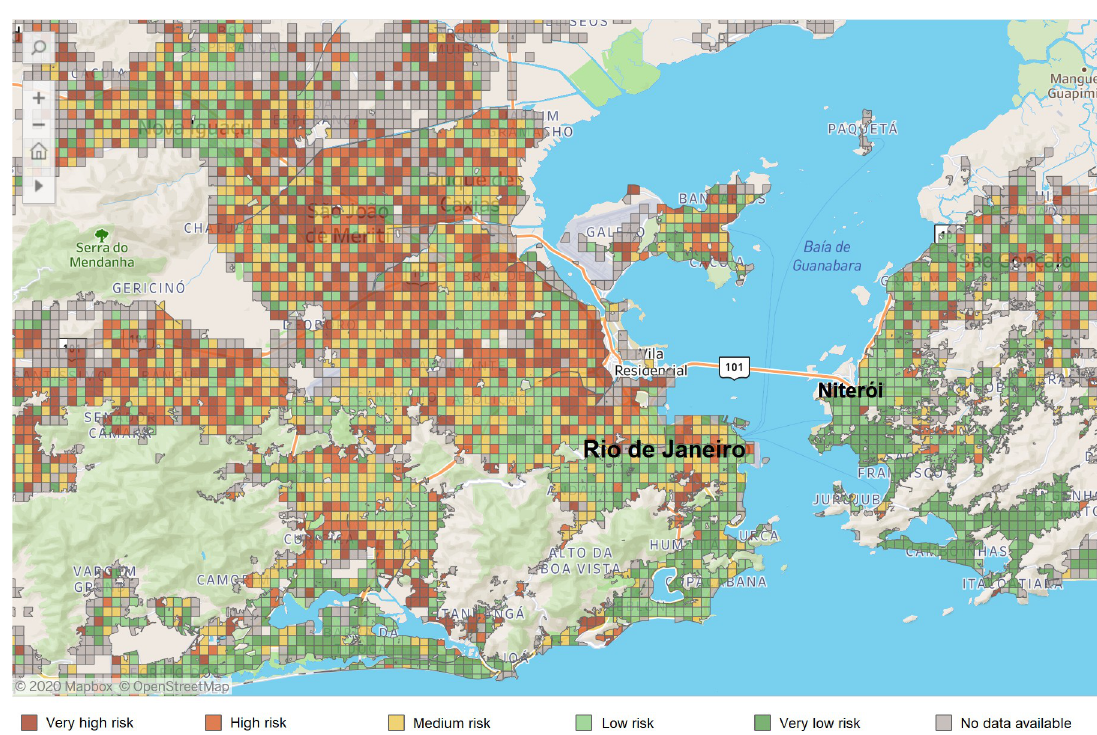
Fig 4. SARS-CoV-2 infection risk map (grid) of Rio de Janeiro state, displaying the city of Rio de Janeiro (capital, left) and the city of Niteroi (right). The grid risk considered the proportion of potential positive infection (observed test results + estimated from the prediction model) for each grid (400mx400m area). The risk groups were obtained as very low ( < 17%), low ( � 17% and < 33%), medium ( � 33% and < 48%), high ( � 48 and < 63%), and very high ( � 63%). The map shows the distribution of risks as of June 10, 2020. Map created by Dados do Bem app using OpenStreetMap @